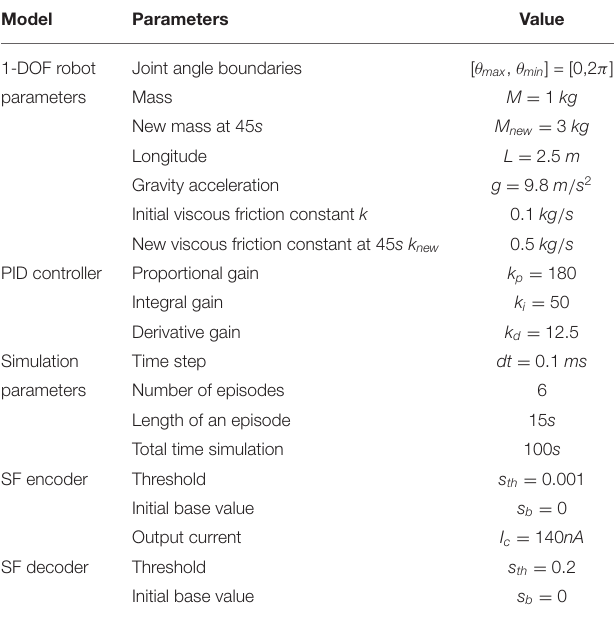
TABLE 5 | 1-link robot simulation